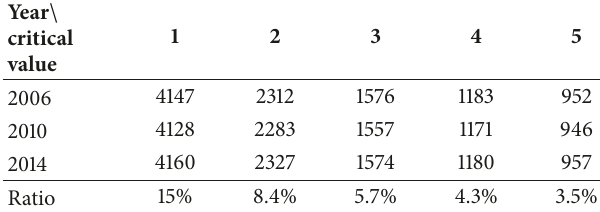
Figure 1: Study area.